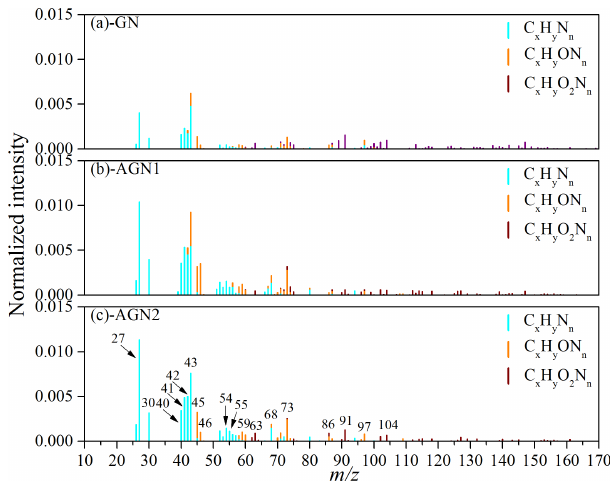
Figure 6. Typical normalized mass spectra of N-containing frag- ments in SOA formed from the photo-oxidation of gasoline vapor at different concentrations of NH 3 (Exps. GN, AGN1, and